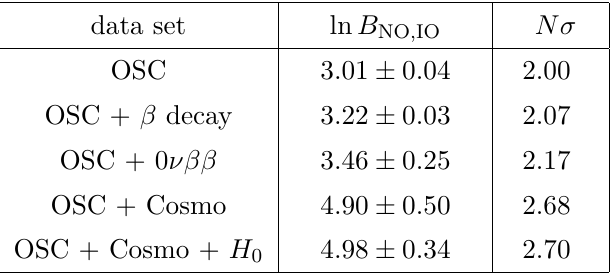
Figure 12 . Bayes factors comparing normal and inverted neutrino mass ordering, using oscillation data alone and in combination with other data sets sensitive to the absolute scale of neutrino masses.